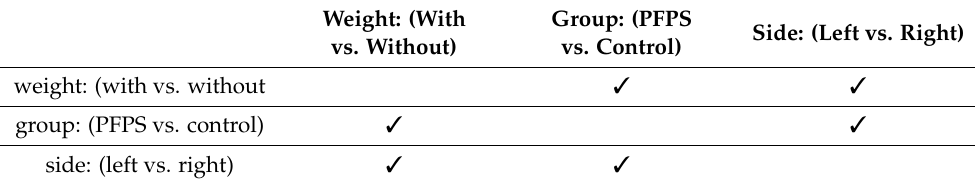
Weight: (With Group: (PFPS Side: (Left vs. Right) vs. Without) vs. Control)